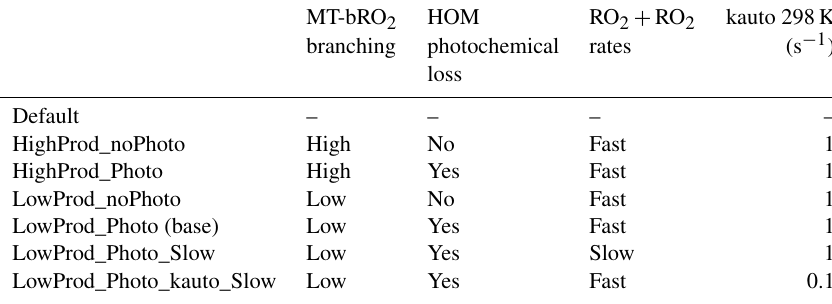
Table 1. Simulations and the corresponding configurations. See the text for details.